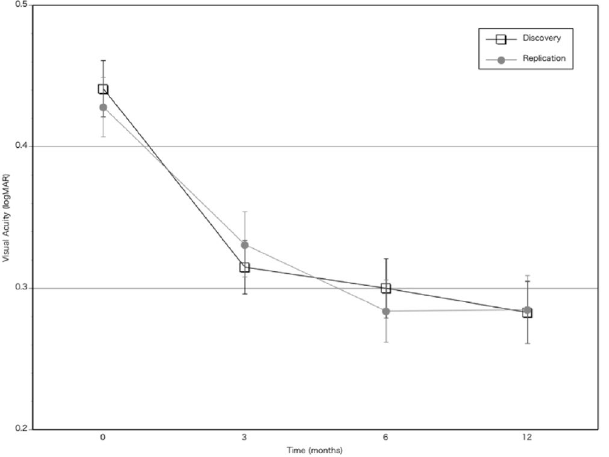
Figure 1. Visual acuity changes during 12 months of ranibizumab treatment in the discovery group (N = 256) and replication group (N = 205). Error bars indicate standard errors of the